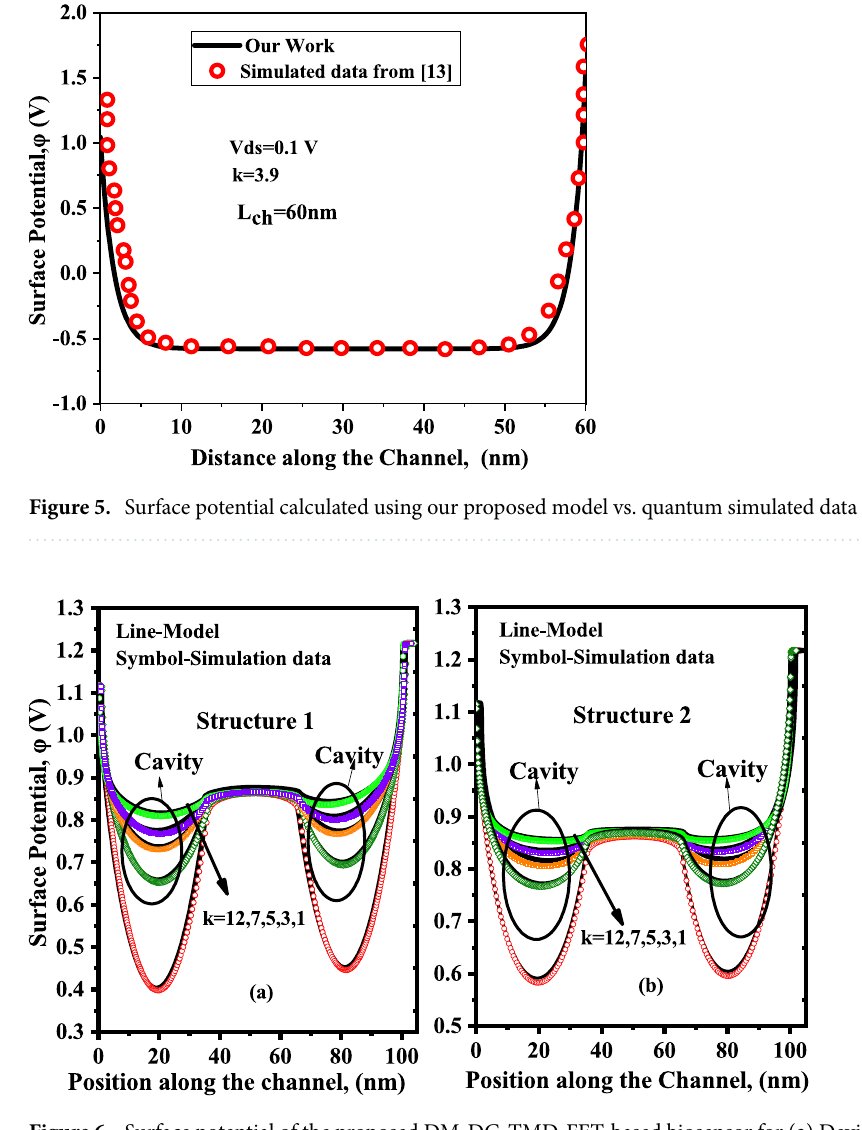
Figure 6. Surface potential of the proposed DM-DG-TMD-FET-based biosensor for ( a ) Device structure-1 and, ( b ) Device structure-2 with different dielectric constants ( κ = 1, 3, 5, 7, 12 ) of biomolecules. ( V gs = 0.1 V , V ds = 0.1 V N f = 0